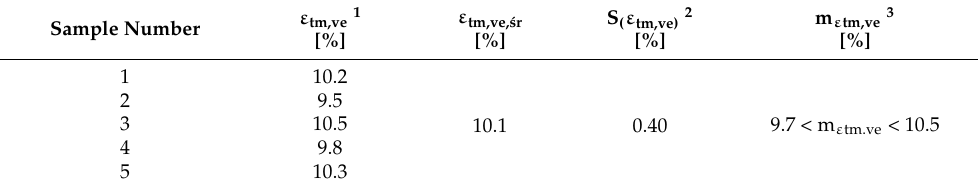
Table 6. Strain results at maximum stress ε tm,ve for a population of 5 samples.